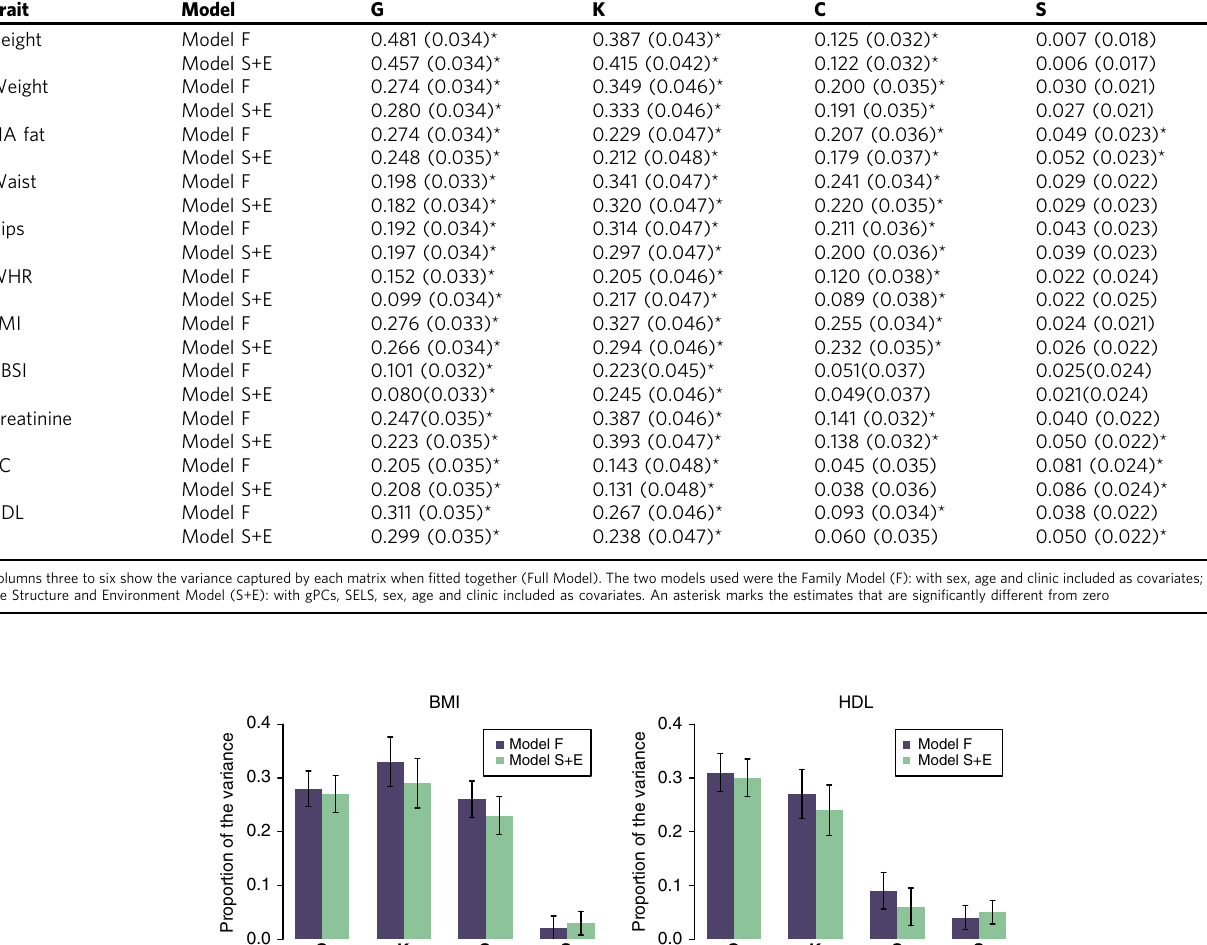
Table 2 Proportion of the phenotypic variance explained by genomic (G: genomic relationship matrix, K: kinship matrix) and environmental matrices (C: couple matrix, S: sibling matrix) Trait